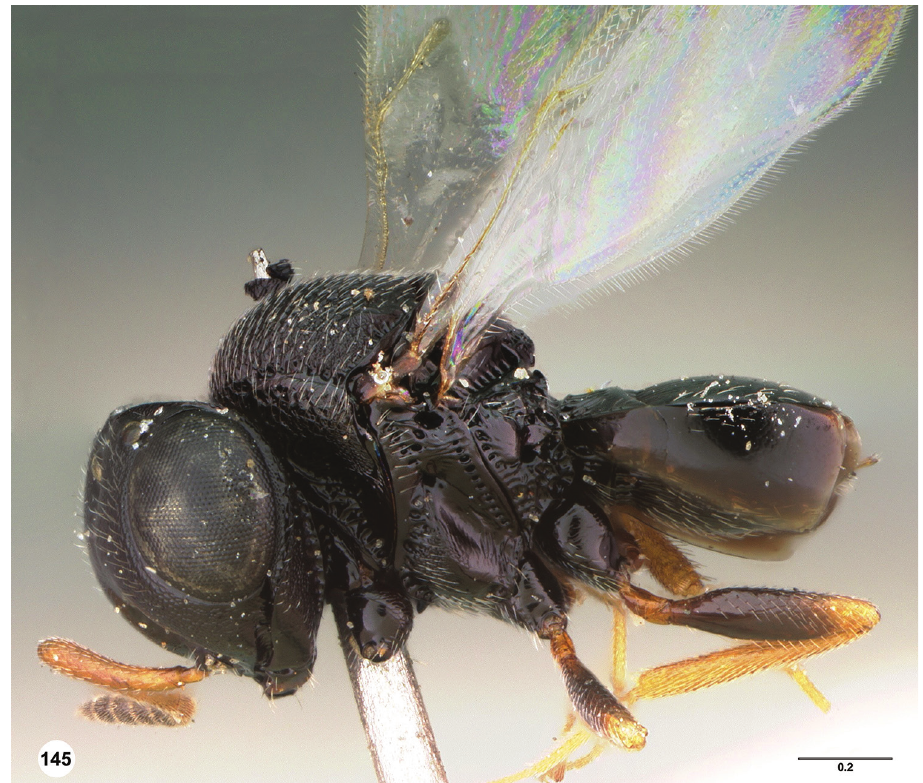
Figure 145. Trissolcus saakowi female lectotype (NHMW 0003), head, mesosoma, metasoma, lateral view. Scale bars in